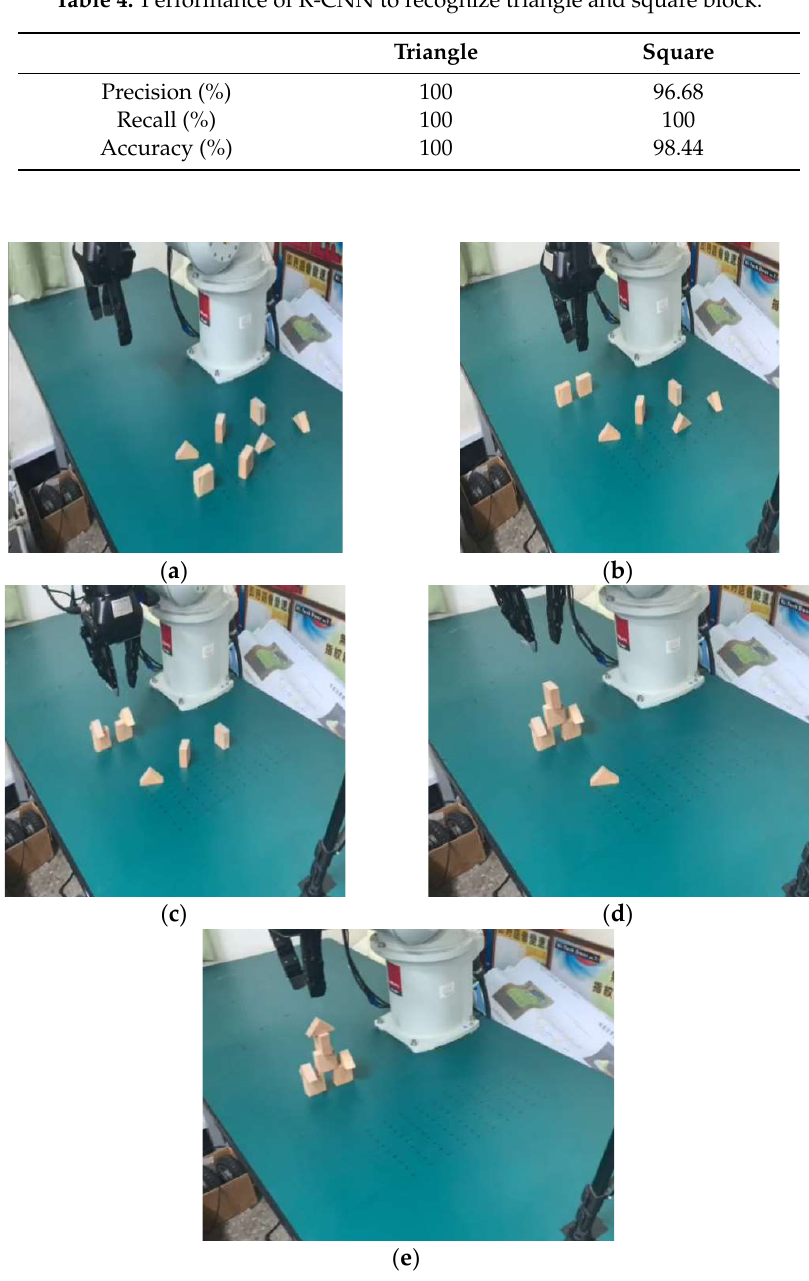
Figure 20. Operation process: ( a )–( e ) The third layout style.